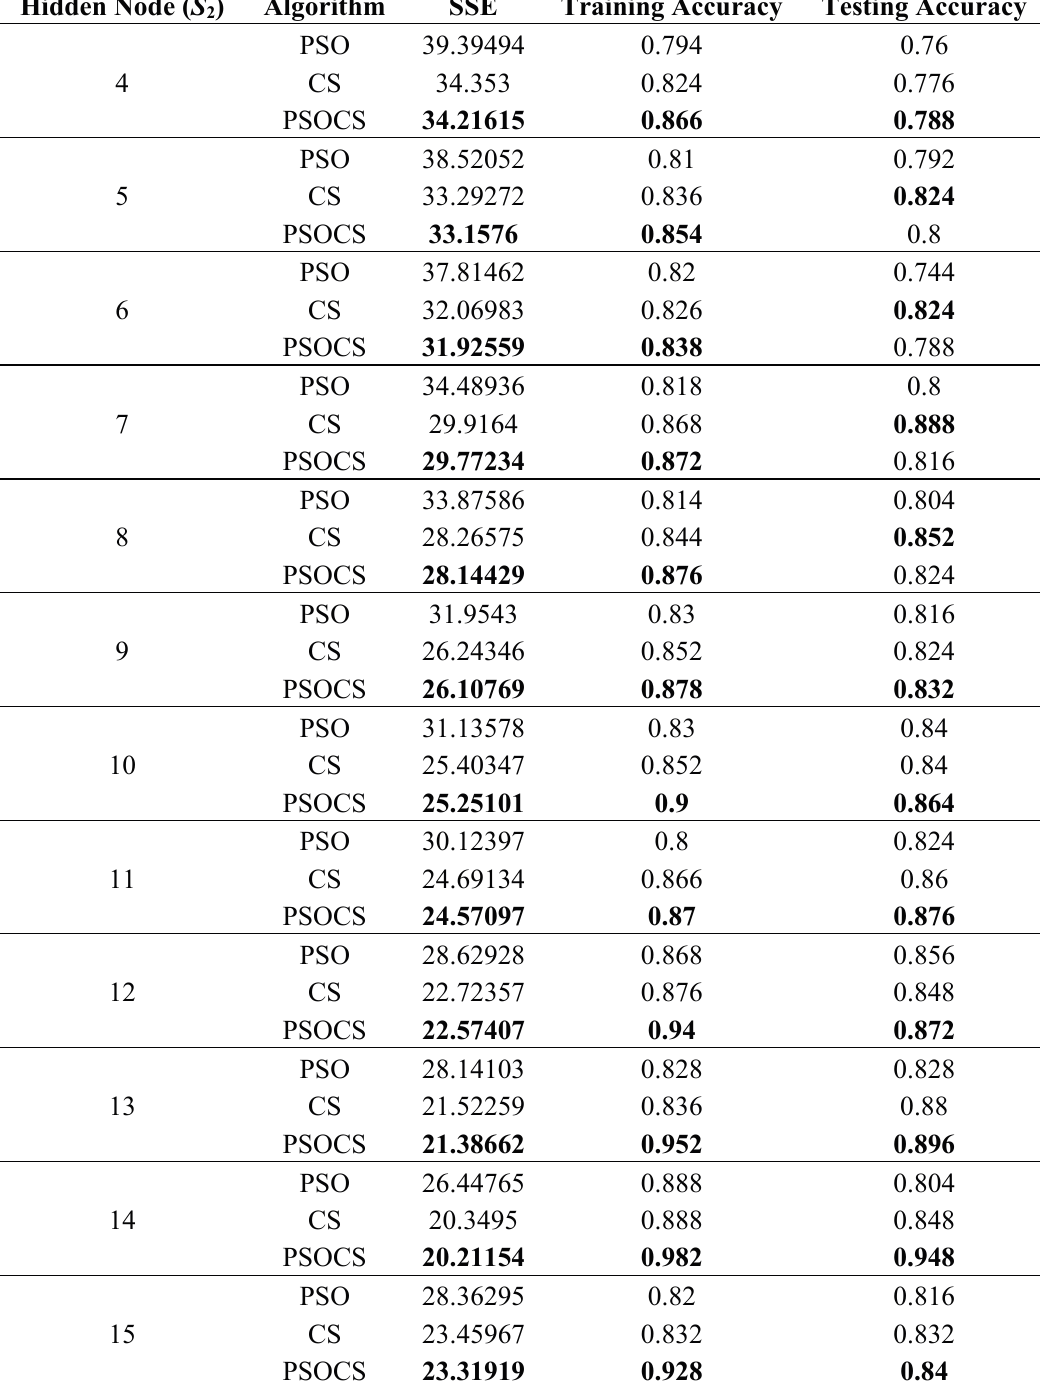
Table 2. The comparison of the performances of the PSO-FNN, CS-FNN, and PSOCS-FNN in the Iris classification